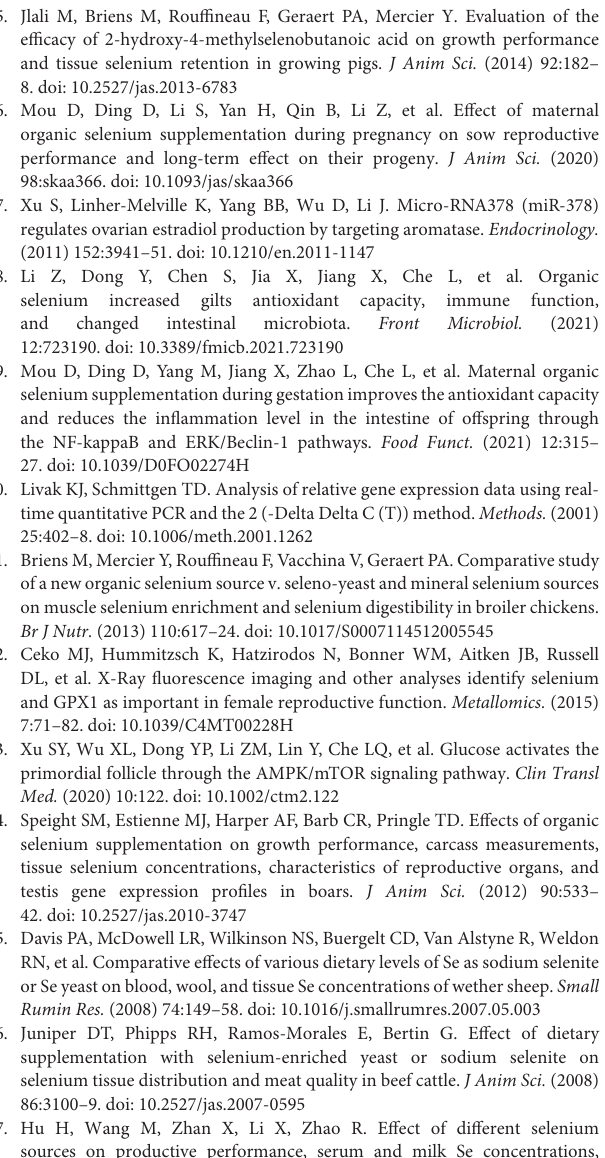
Supplementary Table 2 | Primer sequences of the target genes. SELENOP : selenoprotein P; SELENOW : selenoprotein W; SELENOO : selenoprotein O; SELENOH : selenoprotein H; GPX : glutathione peroxidase; TXNRD : thioredoxin reductase; TXN1 : Thioredoxin l; GR : Glutathione reductase; SOD : superoxide dismutase; CAT : catalase; SCLY : Selenocysteine lyase; SPS2 : Selenophosphate synthetase 2; GDP-9 : growth differentiation factor-9; BMP-15 : bone morphogenetic protein-15; β -actin , beta-actin. Supplementary Table 3 | Effects of dietary selenium supplementation on growth performance in gilts. Data are expressed as means values and standard error, n =